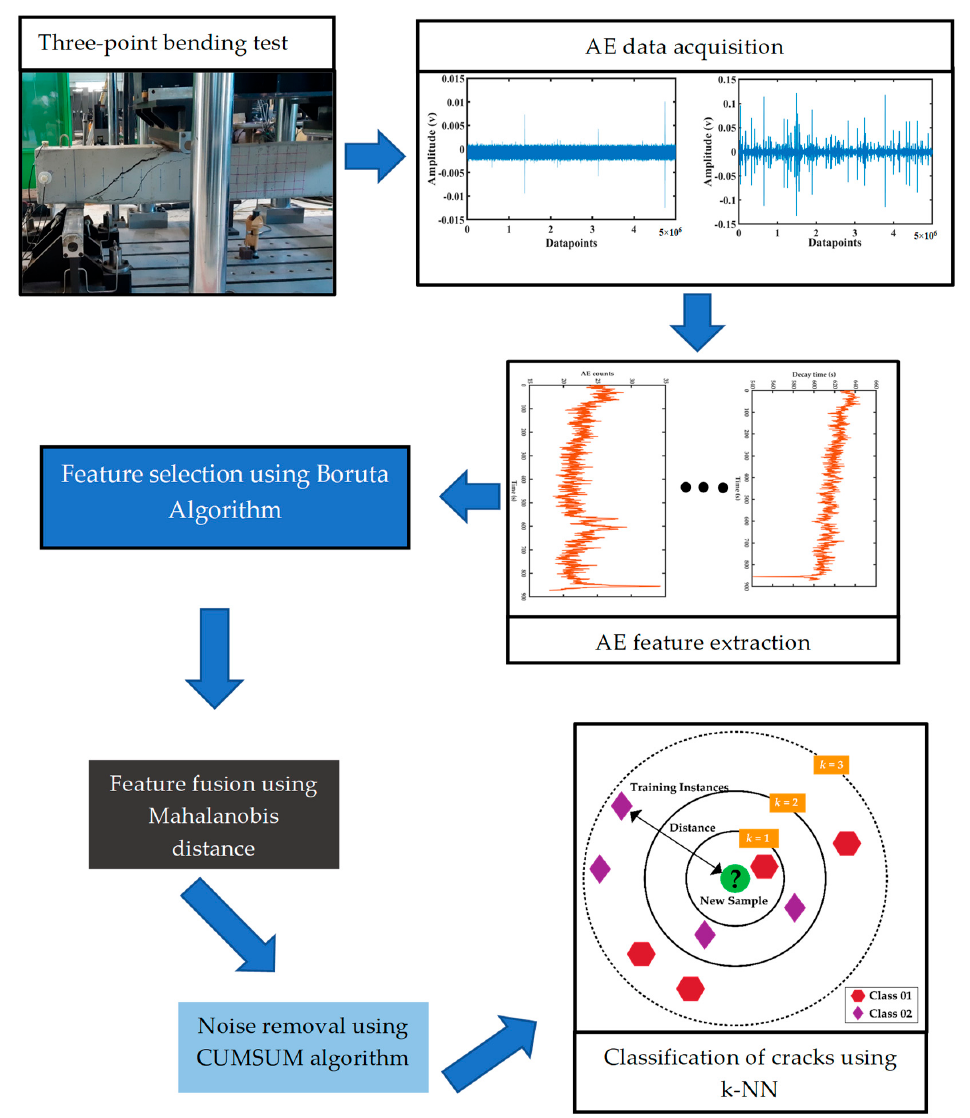
Figure 9. An overview of the proposed method. CUMSUM: cumulative sum.